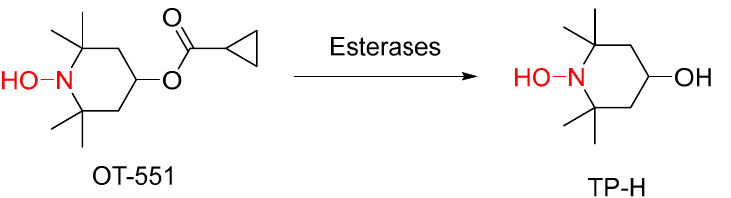
Table 4. Drugs targeting oxidative